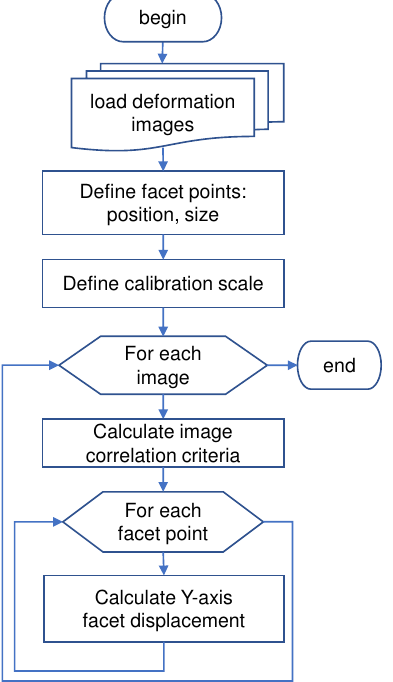
Figure 4. General workflow of DIC displacement measurement from multiple facets in a single plane. The deformation images were cropped beforehand to reduce the computational time of the DIC process. The images would be discarded from DIC analysis if occlusion occurs between the camera and markers due to traffic coming from the sides. Displacement of each facet is estimated based on the position of the region of the image with the highest correlation criteria across multiple frames.